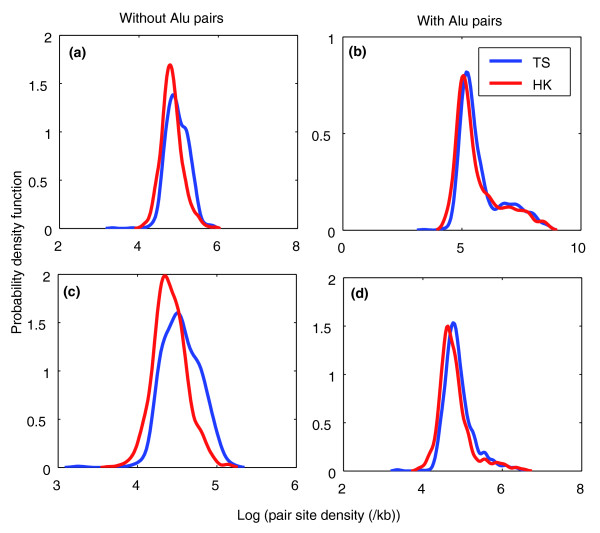
Kernel density plot showing the distribution of short pairs in tissue-specific and housekeeping genes. (a) Pair number density of non-Alu pairs. (b) Pair number density of Alu pairs. (c) Pair site density of non-Alu pairs. (d) Pair site density of Alu pairs. HK, housekeeping genes; TS, tissue-specific genes.